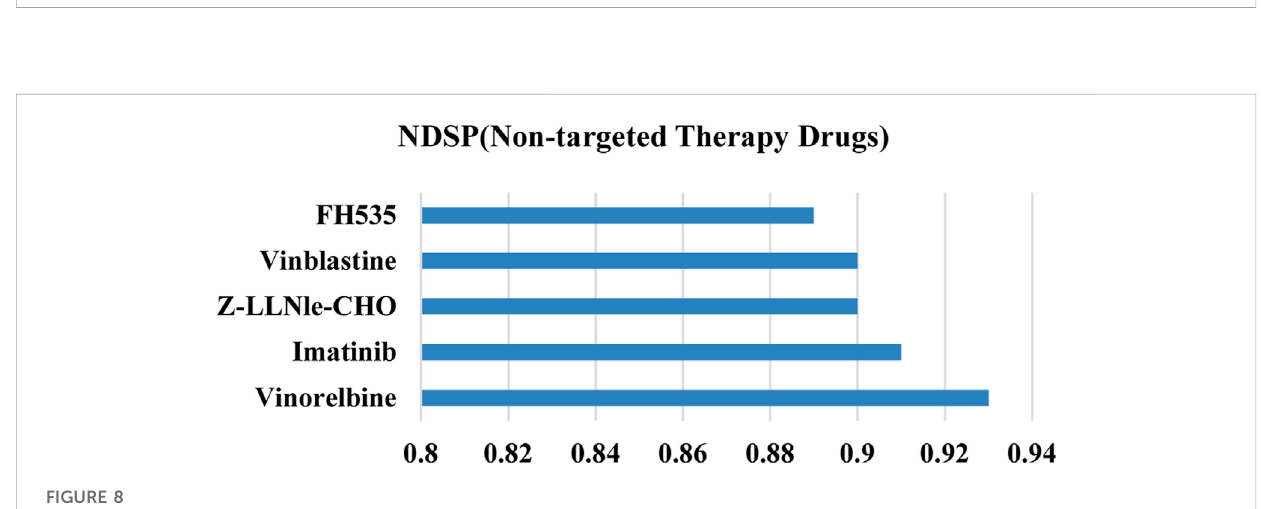
FIGURE 8 Precision of NDSP on non-targeted therapy